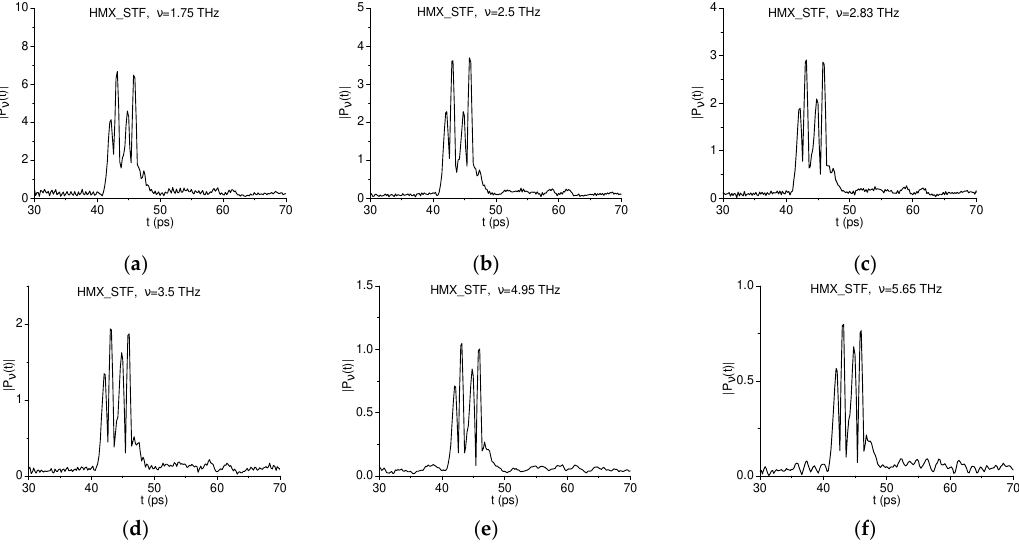
Figure 24. Time-dependent evolution of the HMX_STF spectral amplitudes at the frequencies ν = 1.75 THz ( a ), 2.5 THz ( b ), and 2.83 THz ( c ) and at the corresponding doubled absorption frequen- cies ν = 3.5 THz ( d ), 4.95 THz ( e ), and 5.65 THz ( f